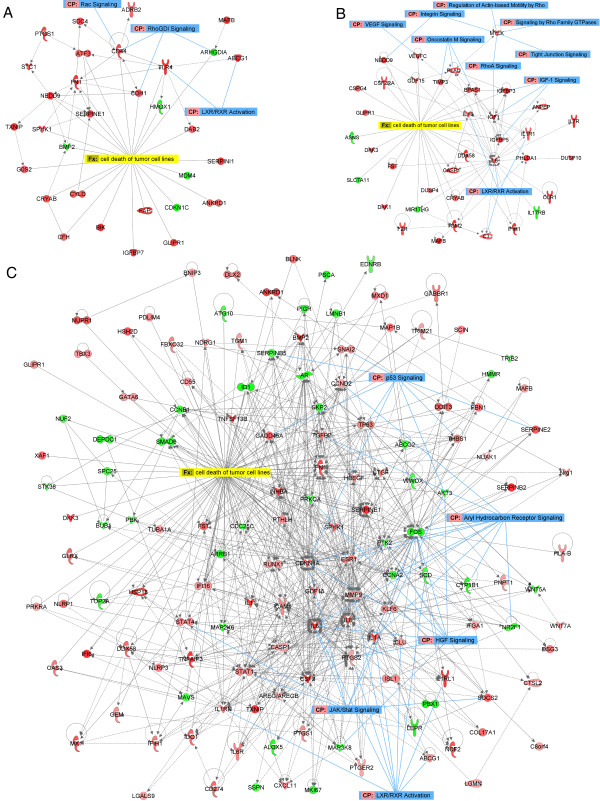
Networks of ‘cell death of tumor cell lines’ function and corresponding transcripts. Networks were constructed with IPA software using genes DE and involved in ‘cell death of tumor cell lines’ following CDV treatment of (A) SiHa, (B) HeLa, or (C) HaCaT cells. A network is a graphical representation of the molecular relationships between molecules (nodes). The biological relationship between two nodes is represented as an edge connecting two nodes. All edges are supported by information from the literature stored in the Ingenuity Pathways Knowledge Base. The intensity of the node color indicates the degree of up-regulation (red) or down-regulation (green) following CDV treatment. Canonical pathways identified by IPA in the networks are shown in blue. Except for DAB2, SERPINI1, CFH, and NEDD9 in SiHa; NEDD9, DKK1, DDX58, CDF15, DUSP4, CASP1, IGFBP3, F2R, SLC7A11, and ASNS in HeLa; XAF1, TRIM21, USP18, TNFSF13B, STAT4, GLRX, DDX58, GEM, TBX3, BMP2, TUBA1A, STAT1, CTGF, IL8, GDF15, CYP1B1, PTHLH, THBS1, CASP1, IL11, CLU, and CTSL2 in HaCaT; no changes in expression for genes included in the cell death networks built for the immortalized cells were observed in PHKs. Notably, BMP2 (SiHa); MYLK (HeLa); and NUPR1, NUF2, SPC25, BUB1, TOP2A, DEPC1, CCNB1, PBK, TGFB2, TP63, ABCG2, CCNA2, MKI67, SSPN, NRG1, MAP3K8, and ALOX5 (HaCaT) were inversely regulated in PHKs.